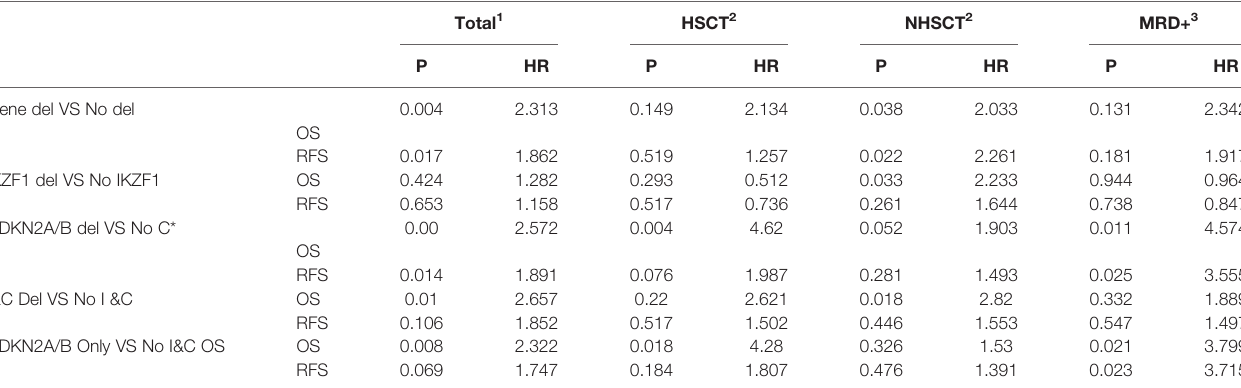
TABLE 4 | COX regression analysis of Ph - B-ALL patients with different gene deletions in different